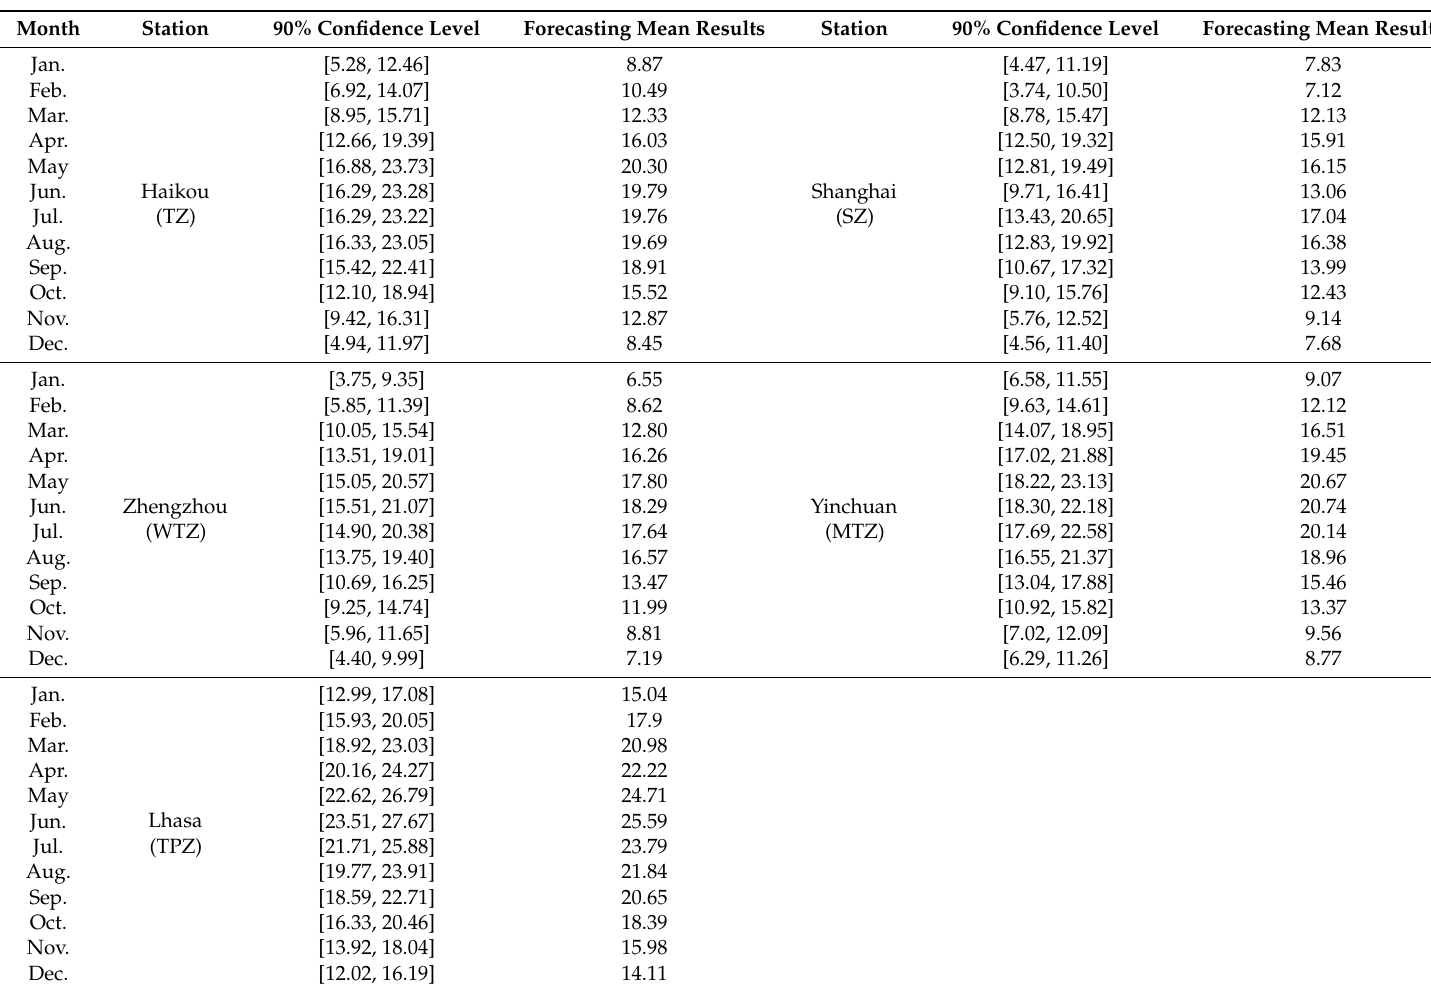
Table A3. The monthly mean solar radiation interval forecasting by 2016 in different climates of